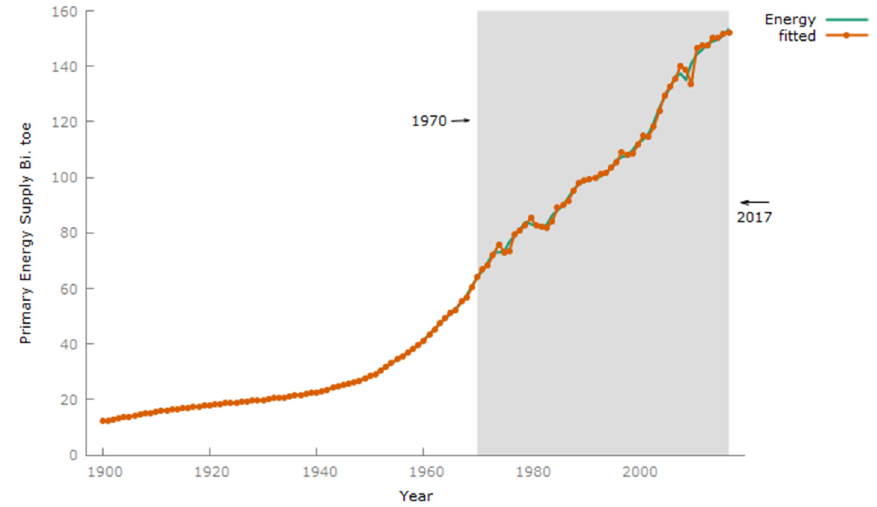
Figure A1. Model fit.